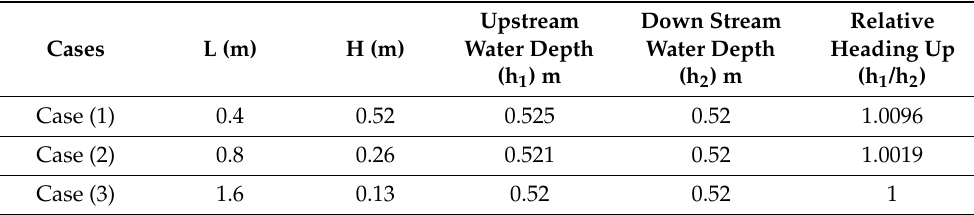
Table 6. The measured water depths upstream and downstream of the biofilter and the resulting relative heading up (h 1 /h 2 ) for a constant volume and variable length and